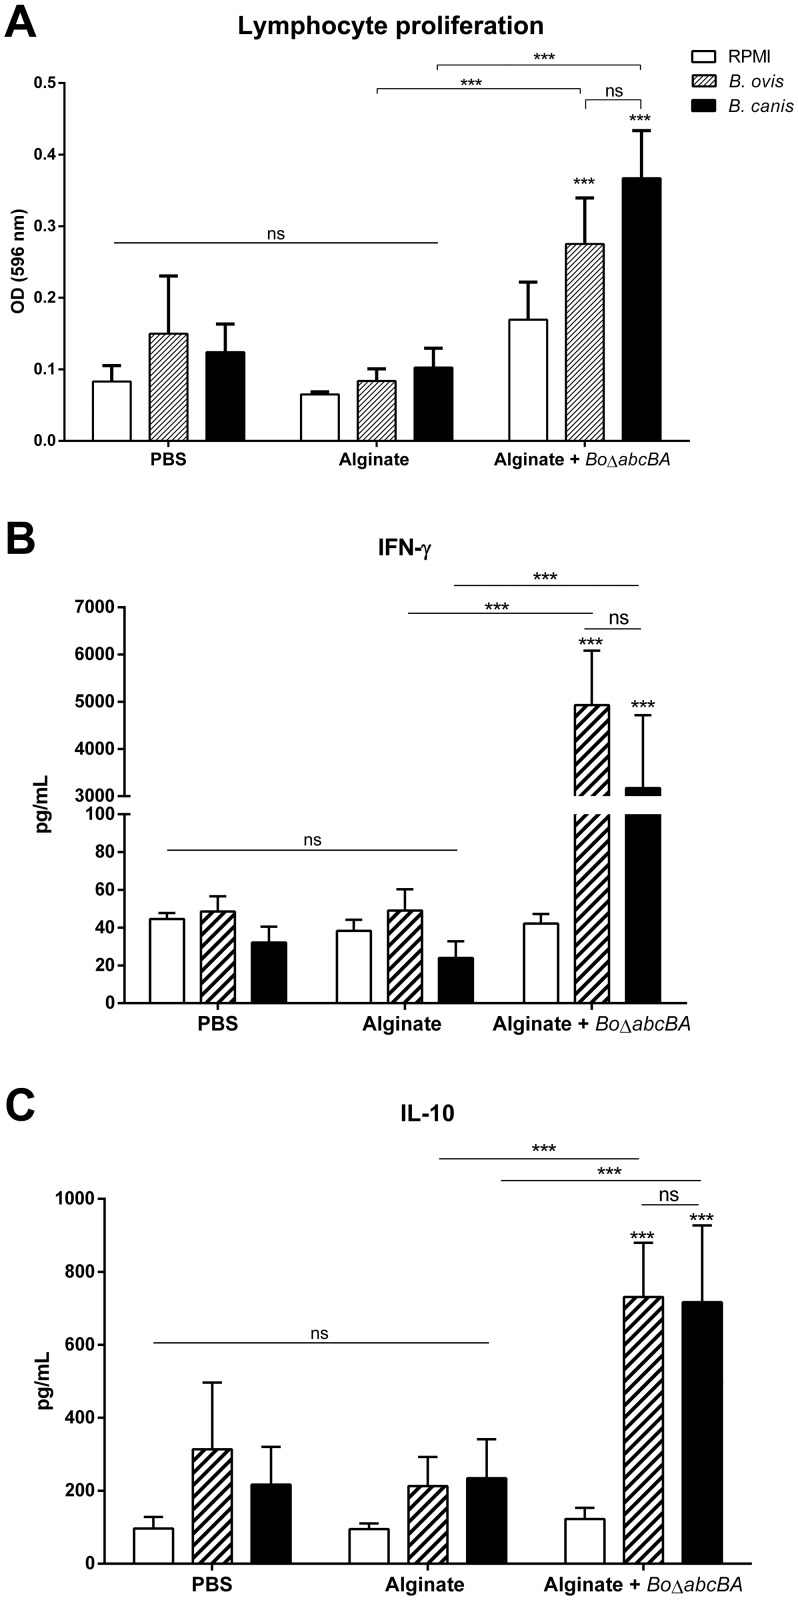
Lymphocyte proliferation assay (A), IFN-γ (B) and IL-10 (C) production by splenocytes from mice immunized with alginate-encapsulated Brucella ovis ΔabcBA (BoΔabcBA; n = 7) or mice inoculated with sterile alginate (n = 7) or PBS (n = 6).(A) After four weeks of immunization, splenocytes of mice (5 x 105) were stimulated with RPMI, B. ovis or B. canis inactivated by gamma irradiation (corresponding to 108 CFU/well) for 72 h and proliferative response were analyzed by MTT assay. Data correspond to the mean and SD at minimum of 6 mice for each group with duplicates. Data were submitted to ANOVA and means were compared using the Tukey test (***p < 0.001). (B and C) Four weeks after immunization, splenocytes were recovered and stimulated with RPMI (negative control), B. ovis or Brucella canis inactivated by gamma irradiation. At 72 h after stimulation, supernatants were recovered and levels of cytokines were evaluated by specific sandwich ELISA. Each data point represents mean and SD of 6 or 7 mice in duplicates for each stimulus. Data were submitted to ANOVA and means were compared using the Tukey test (***p < 0.001).